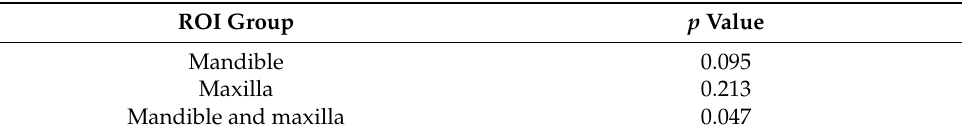
Table 1. p values of Shapiro–Wilk test on each ROI group.